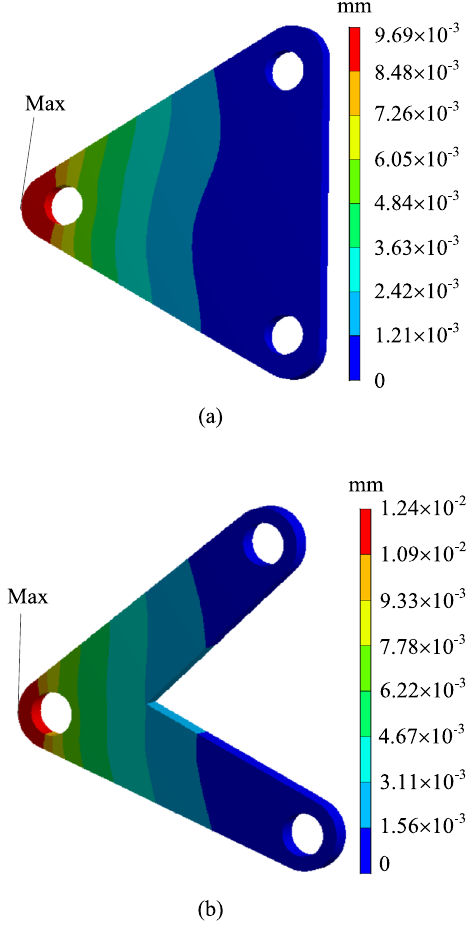
Figure 14. Comparison of displacement contour figures before and after optimization.( a ) Displacement contour figure of the original model ( b ) Displacement contour figure of the reconstructed